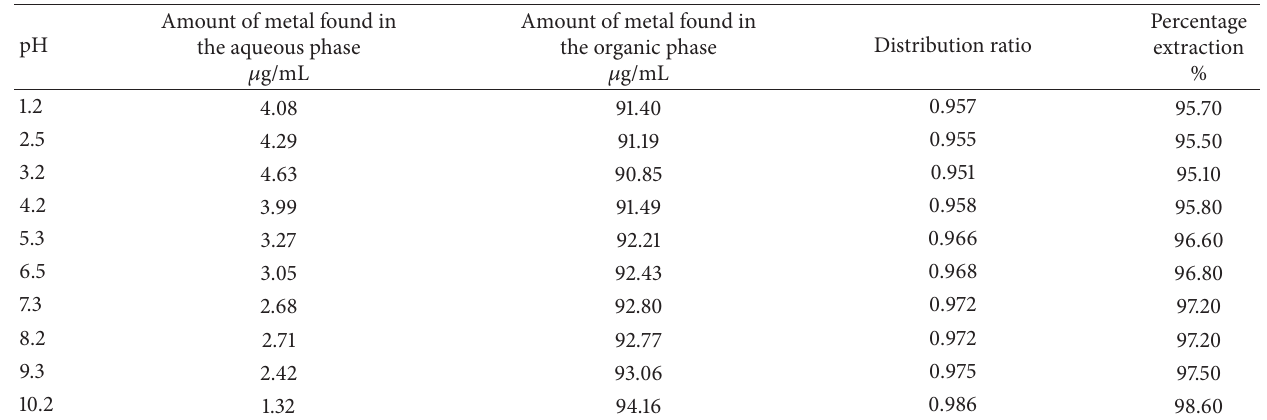
Table 3: Extraction efficiency of copper ion at different pH